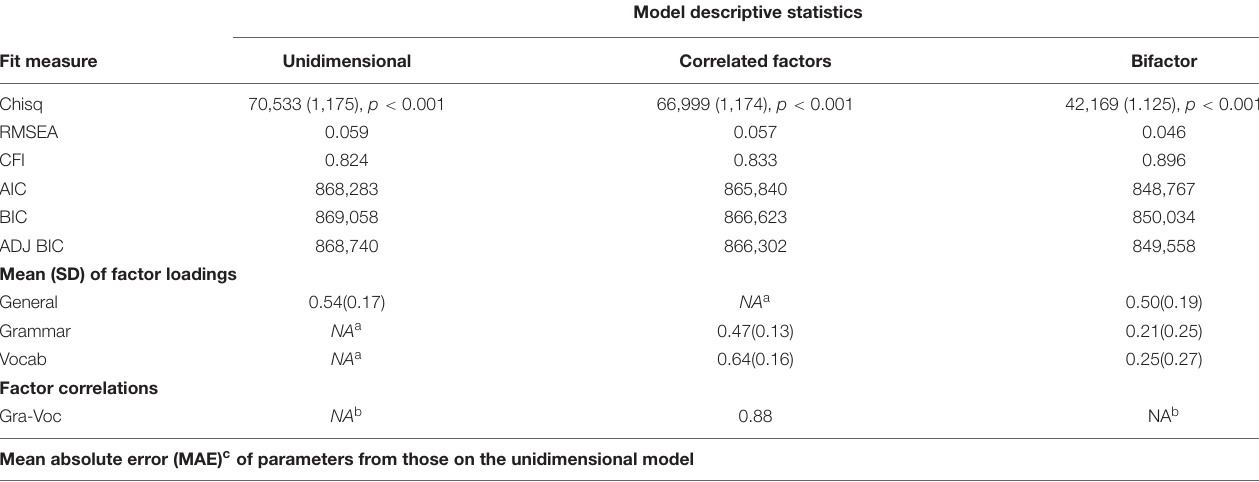
TABLE 1 | Grammar and vocabulary fit measures and average